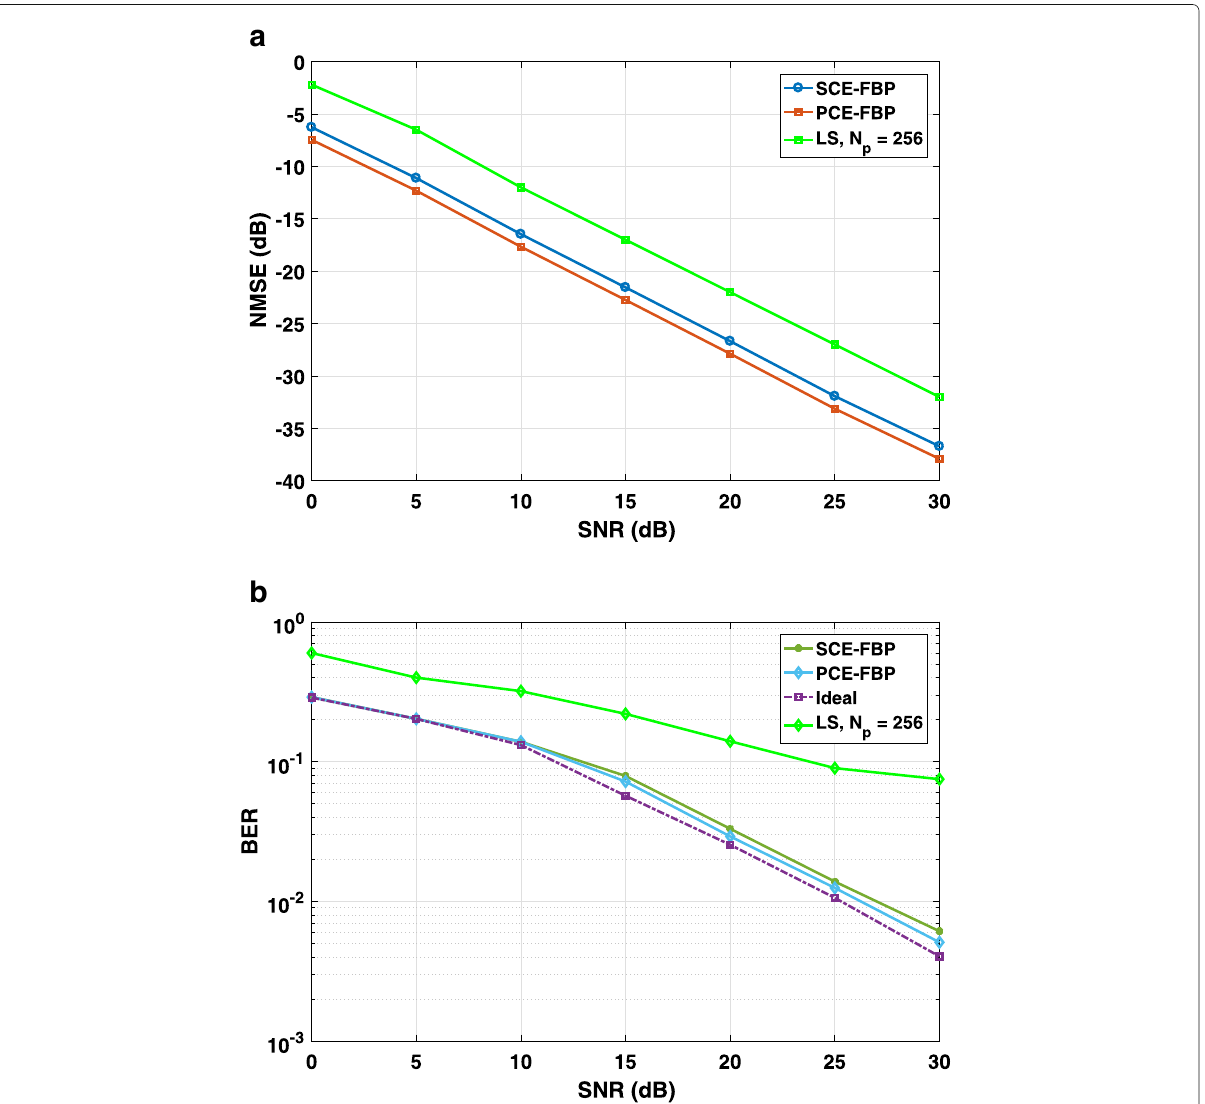
Fig. 6 Performance comparison of proposed method and optimized LS-based pilot allocation algorithm: ( a ) NMSE performance metric, ( b ) BER performance metric is extremely decreased. The simulation parameters for the proposed pilot allocation is as